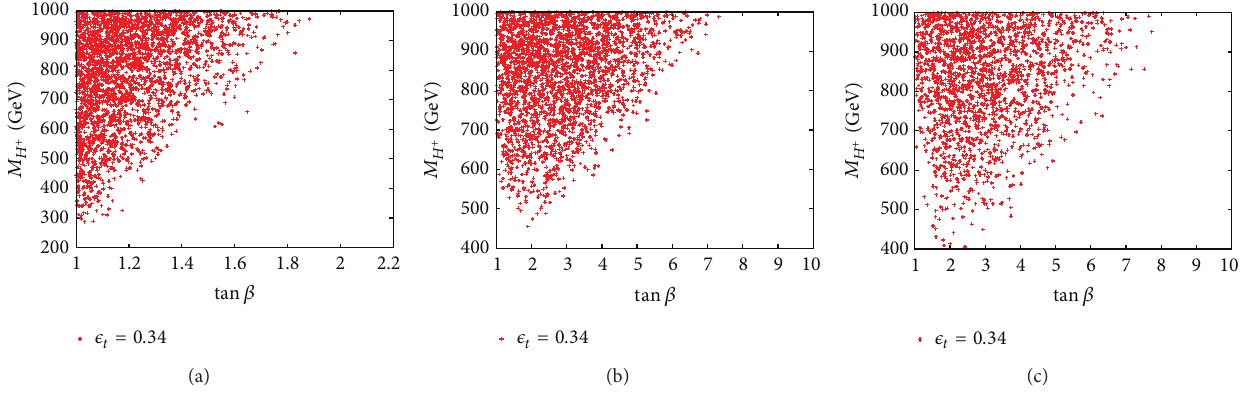
󸀠 | = 0.004 ):theallowedparameterspaceinthe 𝑚 𝑠𝑏